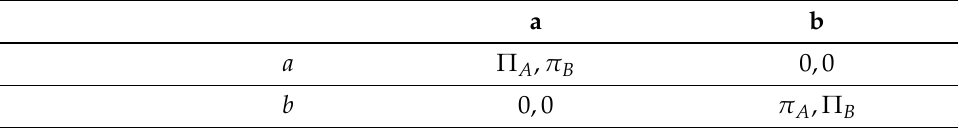
Table 3. Payoff matrix of inter-group